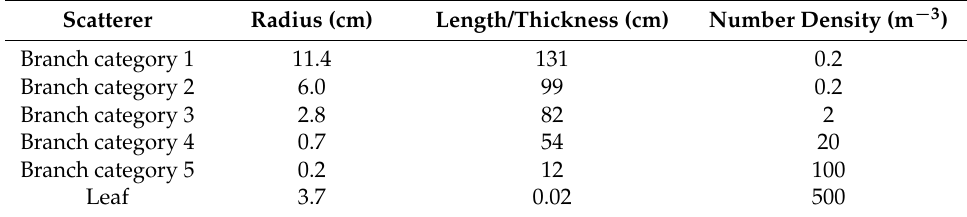
Table 1. Physical parameters of branches and leaves utilized in the simulation.